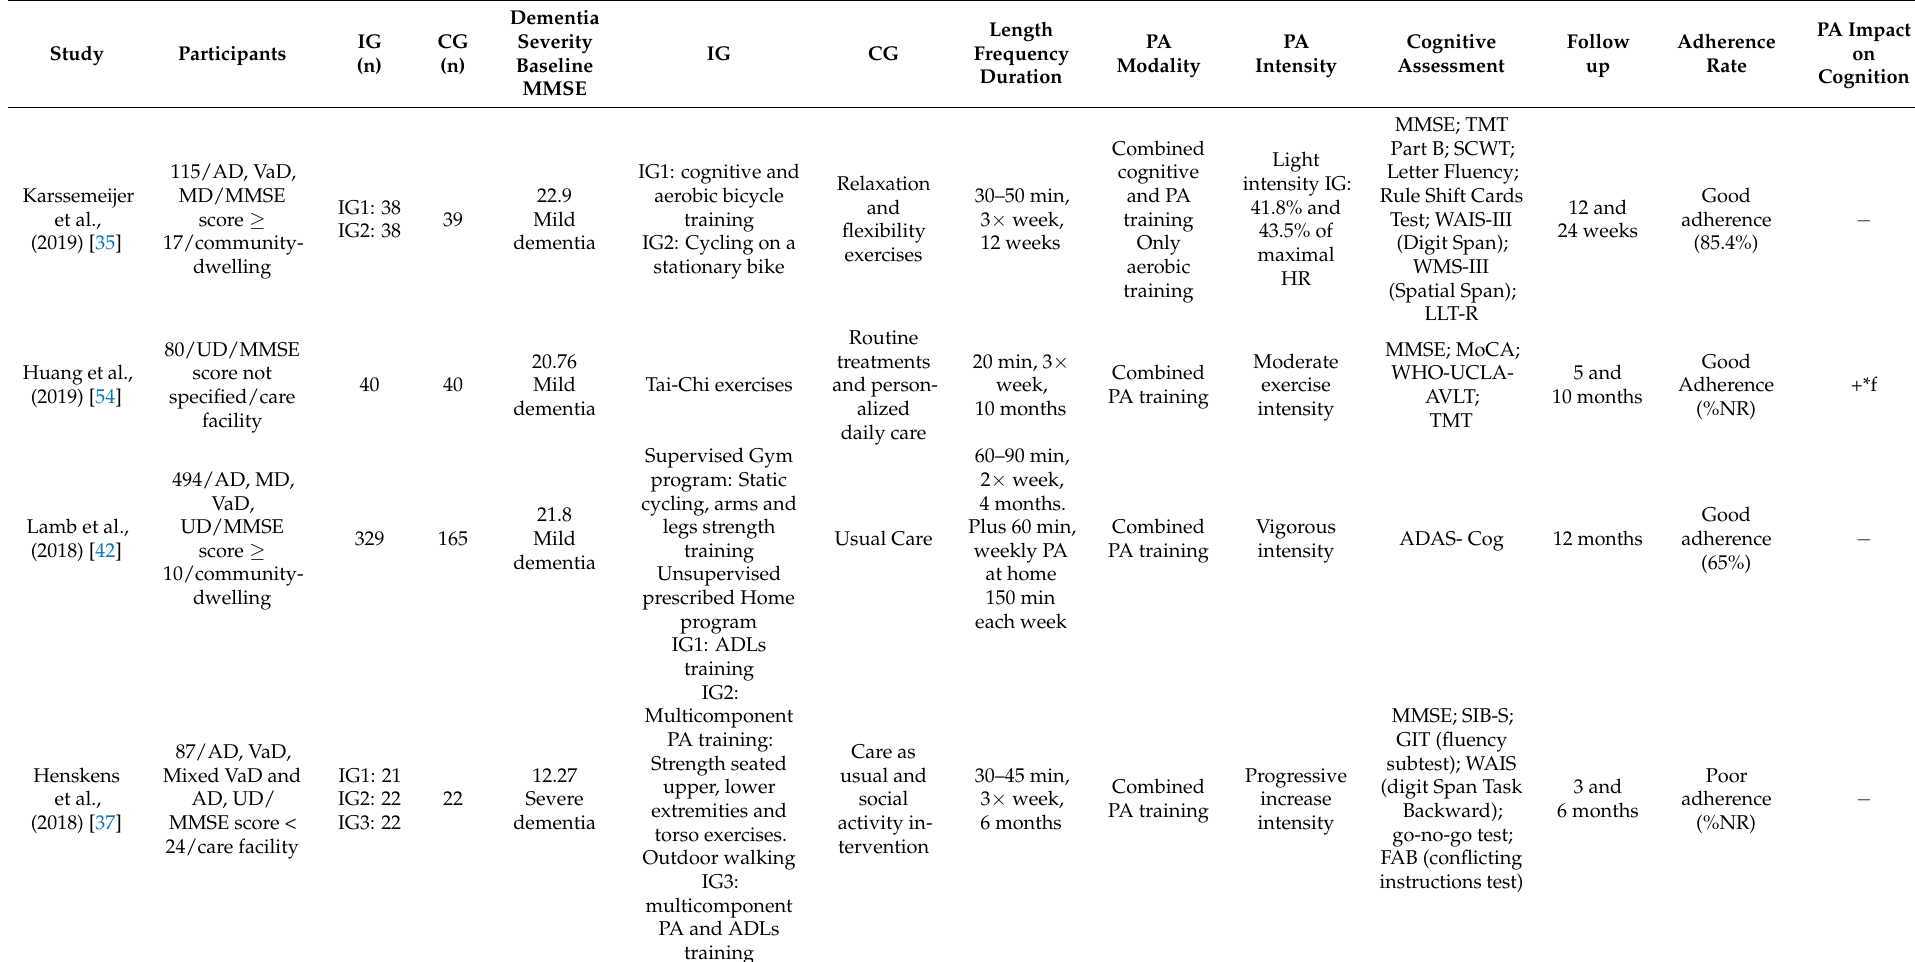
Table 1. Evidence from included RCTs describing PA